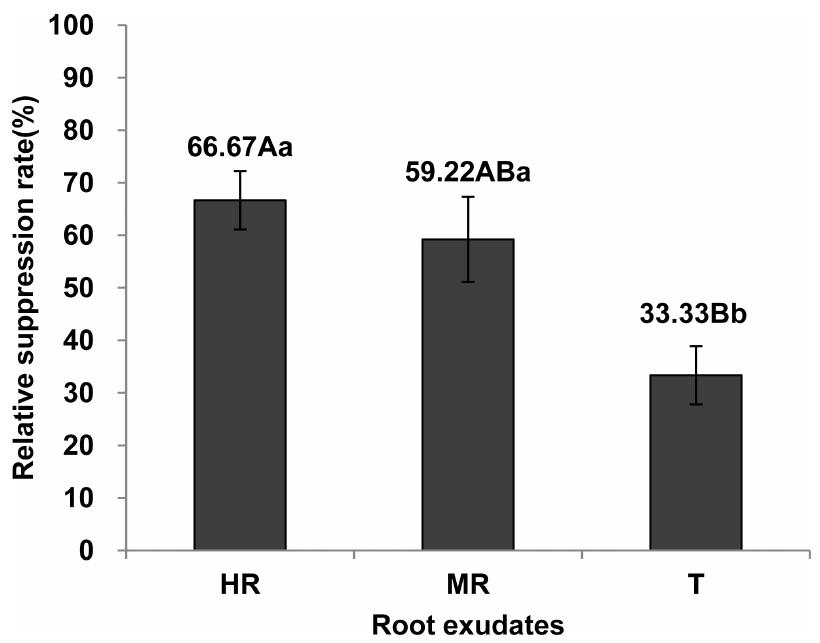
Fig 2. Effects of root exudates on M . incognita egg hatch. HR, MR and T represent the root exudates from three tomato strains: Baliya (highly resistant), RS2 (moderately resistant) and L-402 (highly susceptible), respectively. Total number of J2 in each root exudate (sterilized water as control) was calculated at 8d after starting the assay. Relative suppression rate (%) = (number of J2 in sterilized water — number of J2 in root exudate) / number of J2 in sterilized water × 100. Each bar represents the mean, and error bars indicate standard error of the mean from three replicates. Capital and lower case letters indicate significant group differences at the levels of 0.01 and 0.05,